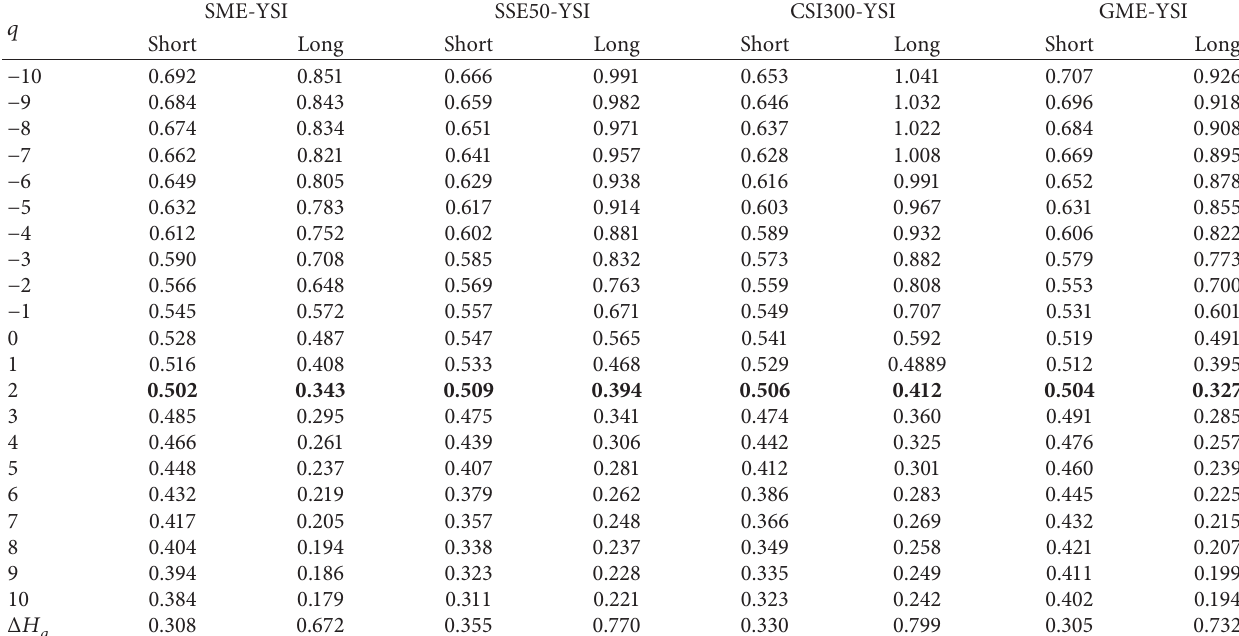
Table 7: Results of the short-term and long-term scaling exponents for Chinese stock market returns.